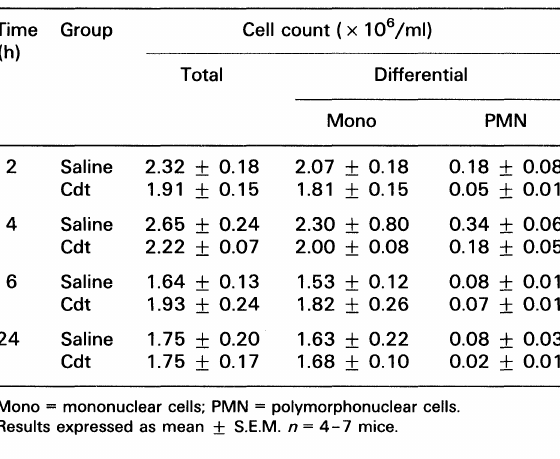
___ (rain) FIG. 2. Time-course of vascular permeability induced by the s.c. injection of 1.51g C.d.terrificus venom in paw of mice. Each S.E.M. of four point is the mean